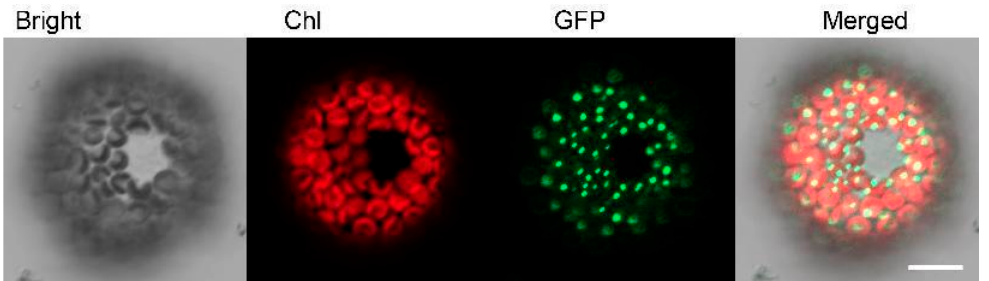
Figure 1. Subcellular location of PhSK. PhSK C-terminal GFP fusion proteins were transiently expressed in petunia protoplasts and visualized by confocal microscopy. Chl, chlorophyll. Scale bars: 5 µ m. Images were processed by Zen 2010 (version 6.0, Carl Zeiss Microscopy GmbH, Germany) software.